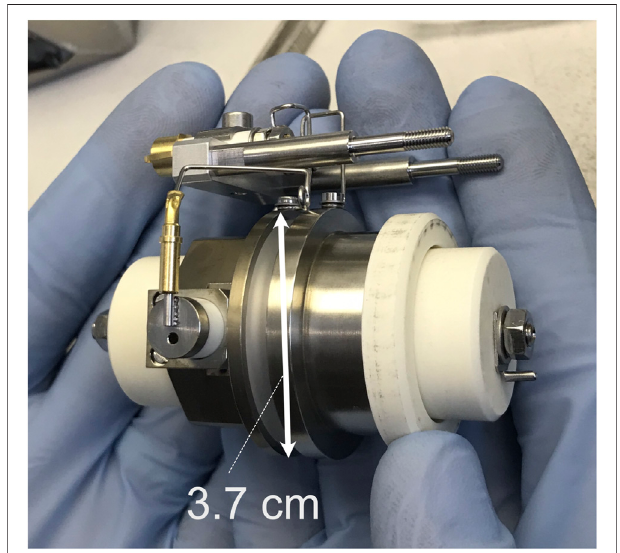
FIGURE 4 | The miniaturized Orbitrap mass analyzer of the Characterization of Ocean Residues And Life Signatures (CORALS) instrument, one of the next generation mass spectrometers currently being developed for space fl ight. Adapted from Willhite et al. (2021).